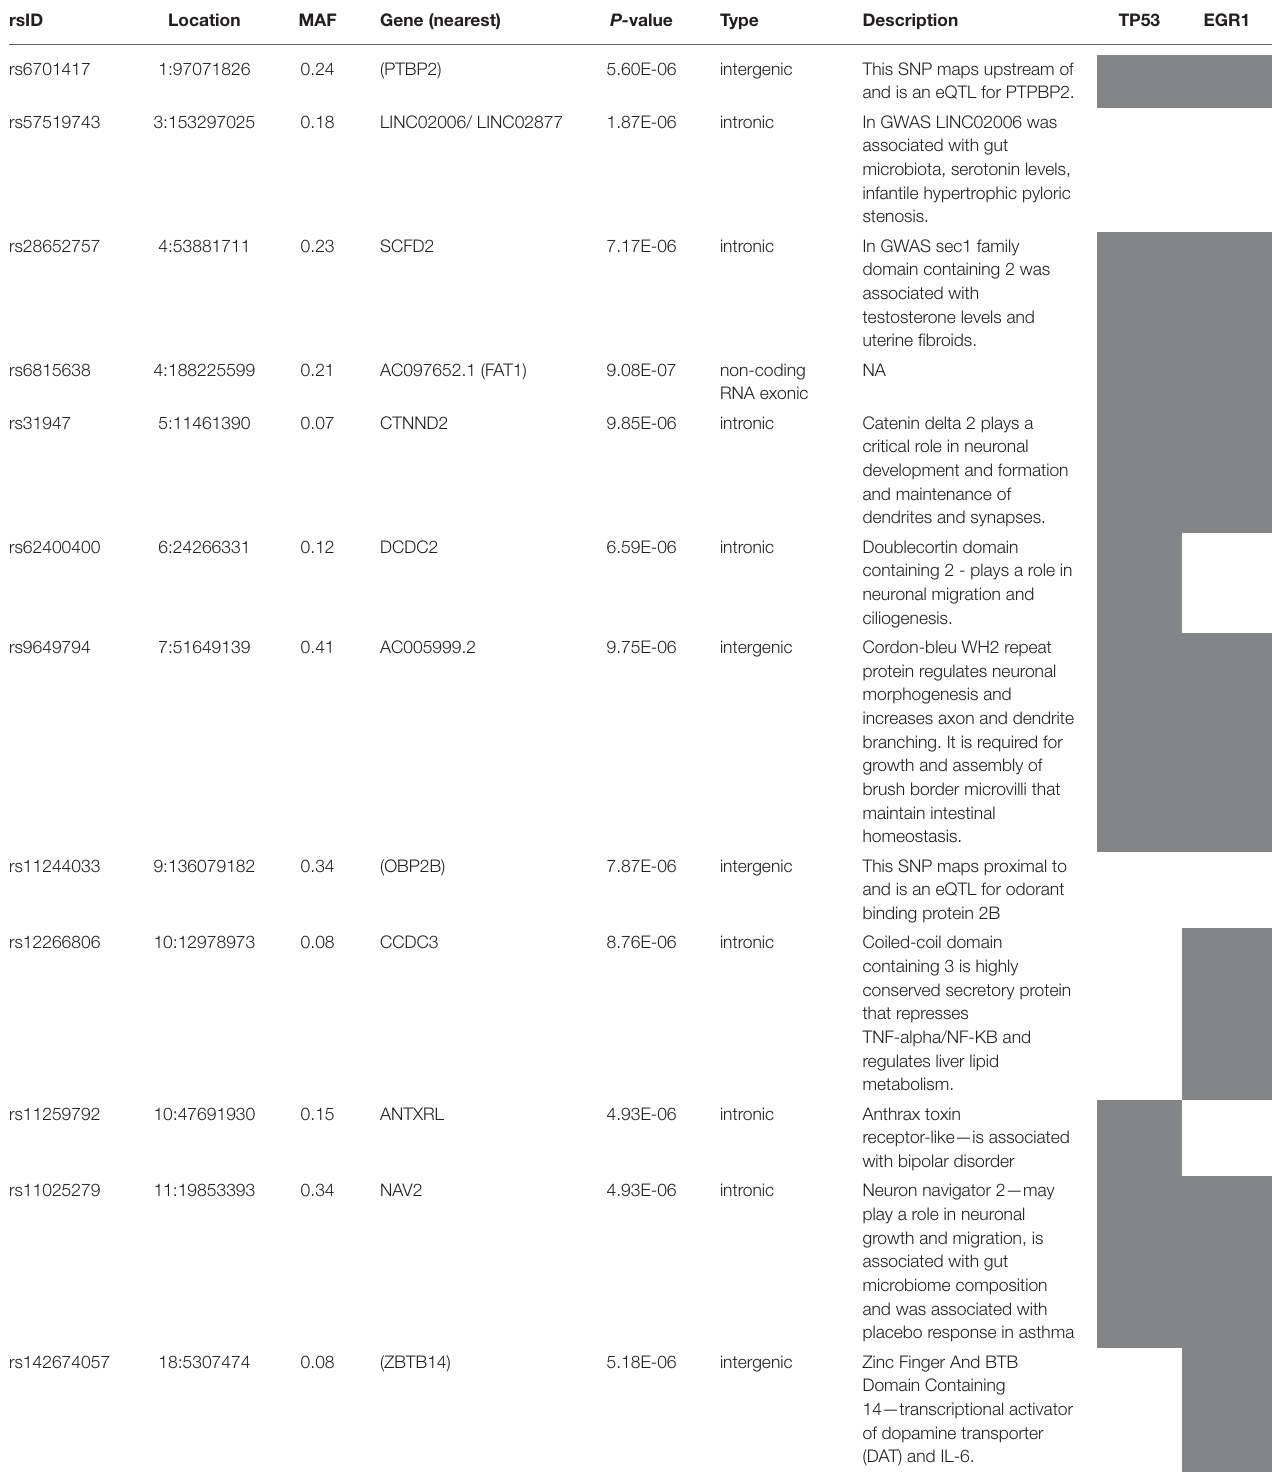
TABLE 2 | Genome-wide suggestive loci associated with the change in IBS-SSS from baseline to 6 weeks in three placebo treatment arms combined.